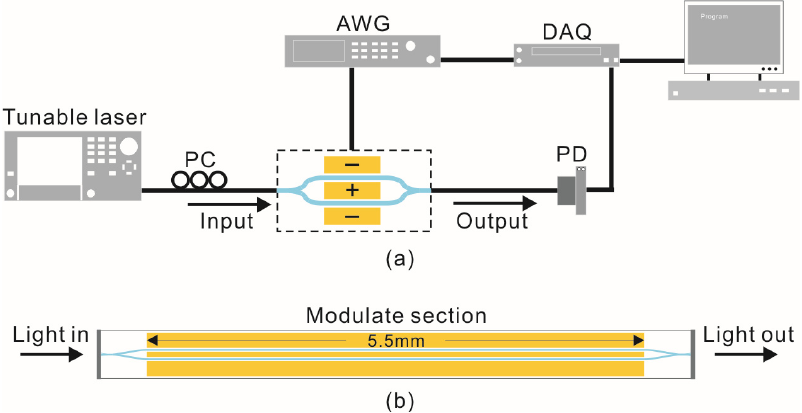
Figure 1. ( a ) The schematic of the FTS; ( b ) The schematic of the TFLN electro-optical